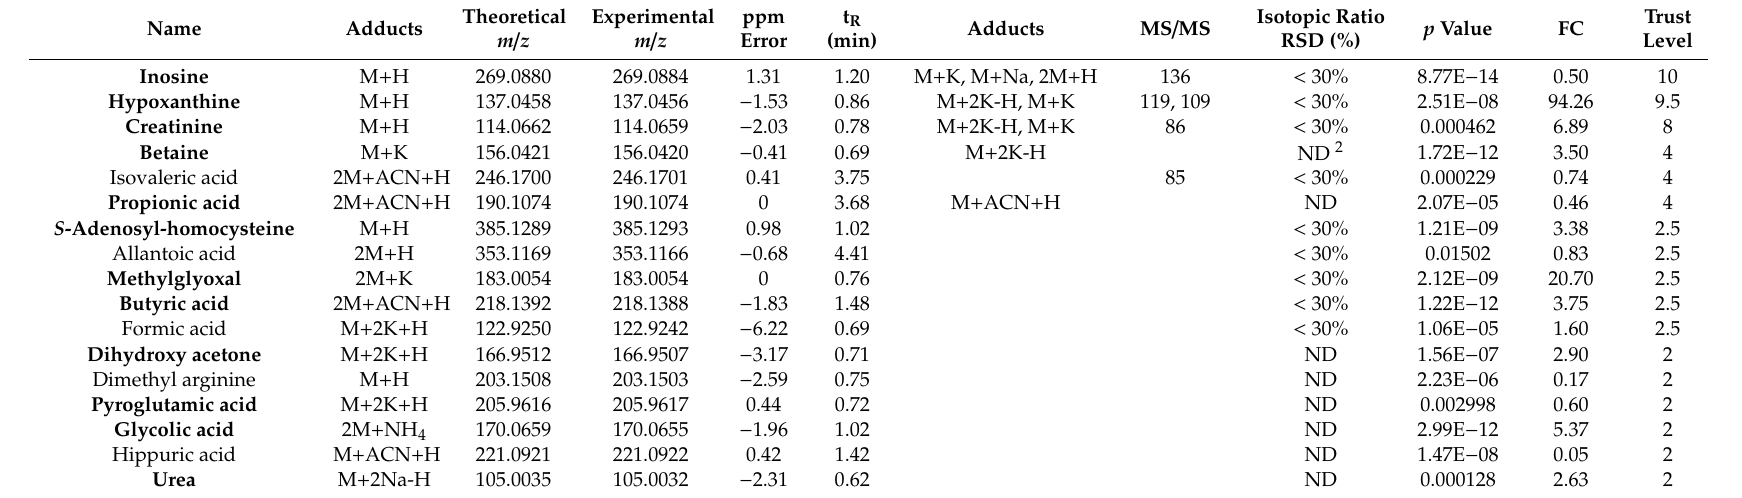
Table 5. Melanoma-originated metabolites 1 identified via targeted screening in positive ionization, and their corresponding detected parent ions, adducts and MS / MS fragments, theoretical and experimental m / z, ppm error, retention time (t R ), isotopic ratio RSD (%), p value, Fold Change (FC) and reliability